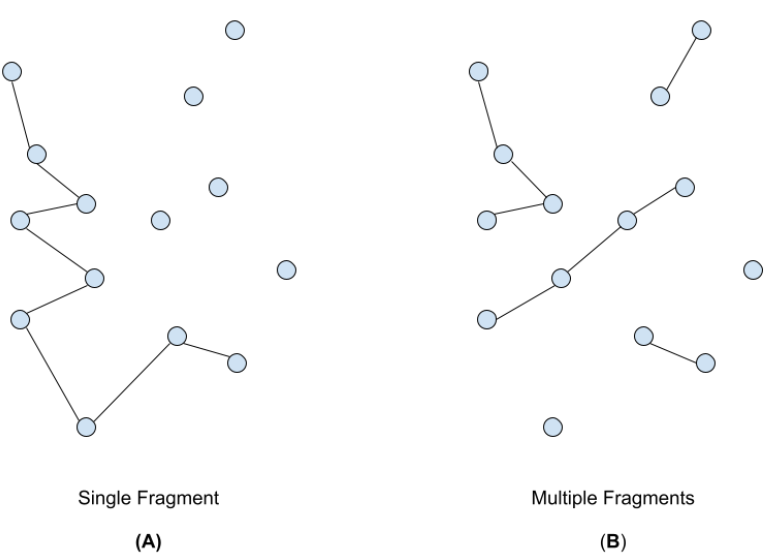
Figure 1. ( A ) Single fragment constructor that operates similarly to NN. ( B ) Constructor that growths multiple fragments similarly to MF and